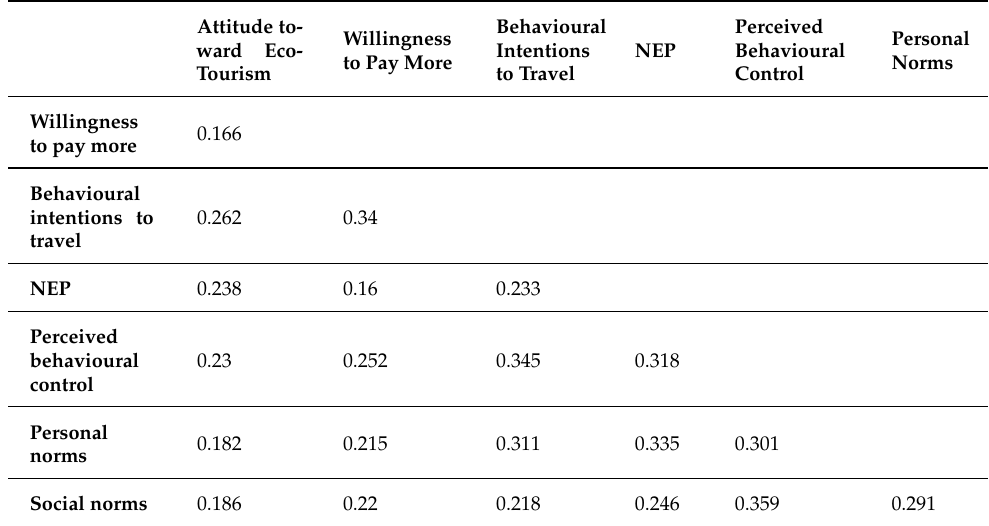
Table 3. Discriminant validity: Heterotrait–Monotrait (HTMT) ratio of the